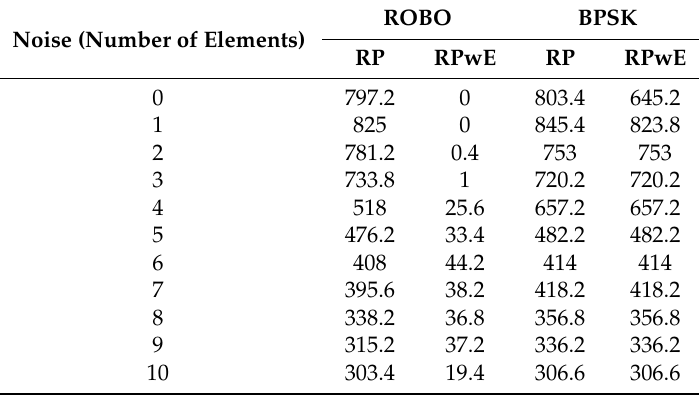
Table 8. ROBO and - BPSK Modulations (List of received packets according to Noise inserted, from Rx to